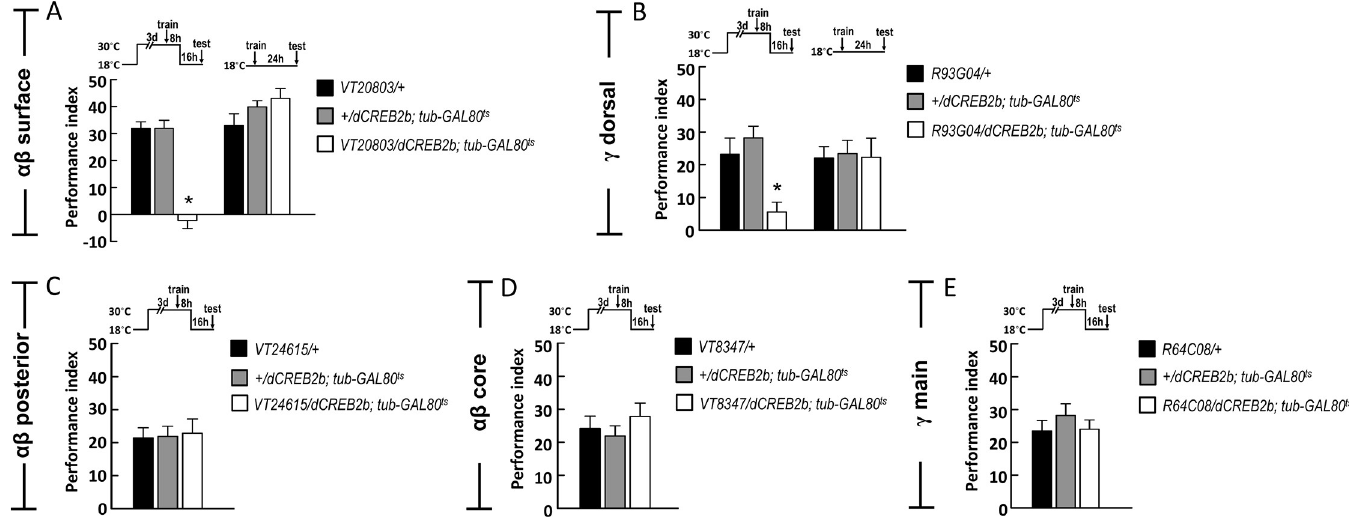
Fig 5. Adult stage-specific expression of dCREB2b in αβ surface or γ dorsal neurons disrupts wLTM. (A) Inducible expression of dCERB2b in αβ surface neurons ( VT20803-GAL4 ) disrupted wLTM. The 24-hour water-reward memory was disrupted in flies carrying VT20803-GAL4 > UAS-dCREB2b; tub-GAL80 ts compared to their internal controls. Each value represents mean ± SEM (N = 8). � , p < 0.05; one-way ANOVA followed by Tukey’s test. (B) Inducible expression of dCERB2b in γ dorsal neurons disrupted wLTM. The 24-hour water-reward memory was disrupted in flies carrying R93G04-GAL4 > UAS-dCREB2b; tub-GAL80 ts compared to their internal controls. Each value represents mean ± SEM (N = 8~10). � , p < 0.05; one-way ANOVA followed by Tukey’s test. (C) Inducible expression of dCERB2b in αβ posterior ( VT24615-GAL4 ) did not affect wLTM. The 24-hour water-reward memory was normal in flies carrying VT24615-GAL4 > UAS-dCREB2b; tub-GAL80 ts compared to their internal controls. Each value represents mean ± SEM (N = 8~10). p > 0.05; one-way ANOVA. (D) Inducible expression of dCERB2b in αβ core ( VT8347-GAL4 ) neurons did not affect wLTM. The 24-hour water-reward memory was normal in flies carrying VT8347-GAL4 > UAS-dCREB2b; tub-GAL80 ts compared to their internal controls. Each value represents mean ± SEM (N = 8~10). p > 0.05; one-way ANOVA. (E) Inducible expression of dCERB2b in γ main ( R64C08-GAL4 ) neurons did not affect wLTM. The 24-hour water-reward memory was normal in flies carrying R64C08-GAL4 > UAS-dCREB2b; tub-GAL80 ts compared to their internal controls. Each value represents mean ± SEM (N = 8~10). p > 0.05; one-way ANOVA.